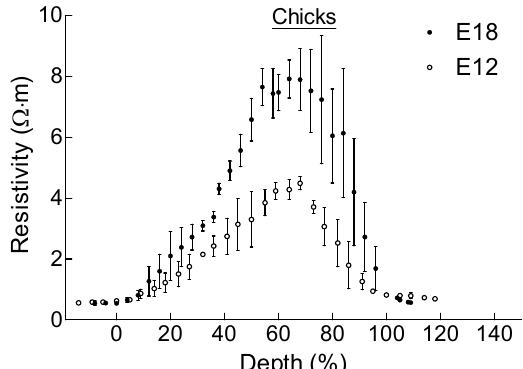
Fig. 8: Mean resistivity ( ± SD) vs. percentage depth profile of three rat retina samples which are extracted from 1416 day old postnatal wildtype juvenile rats.